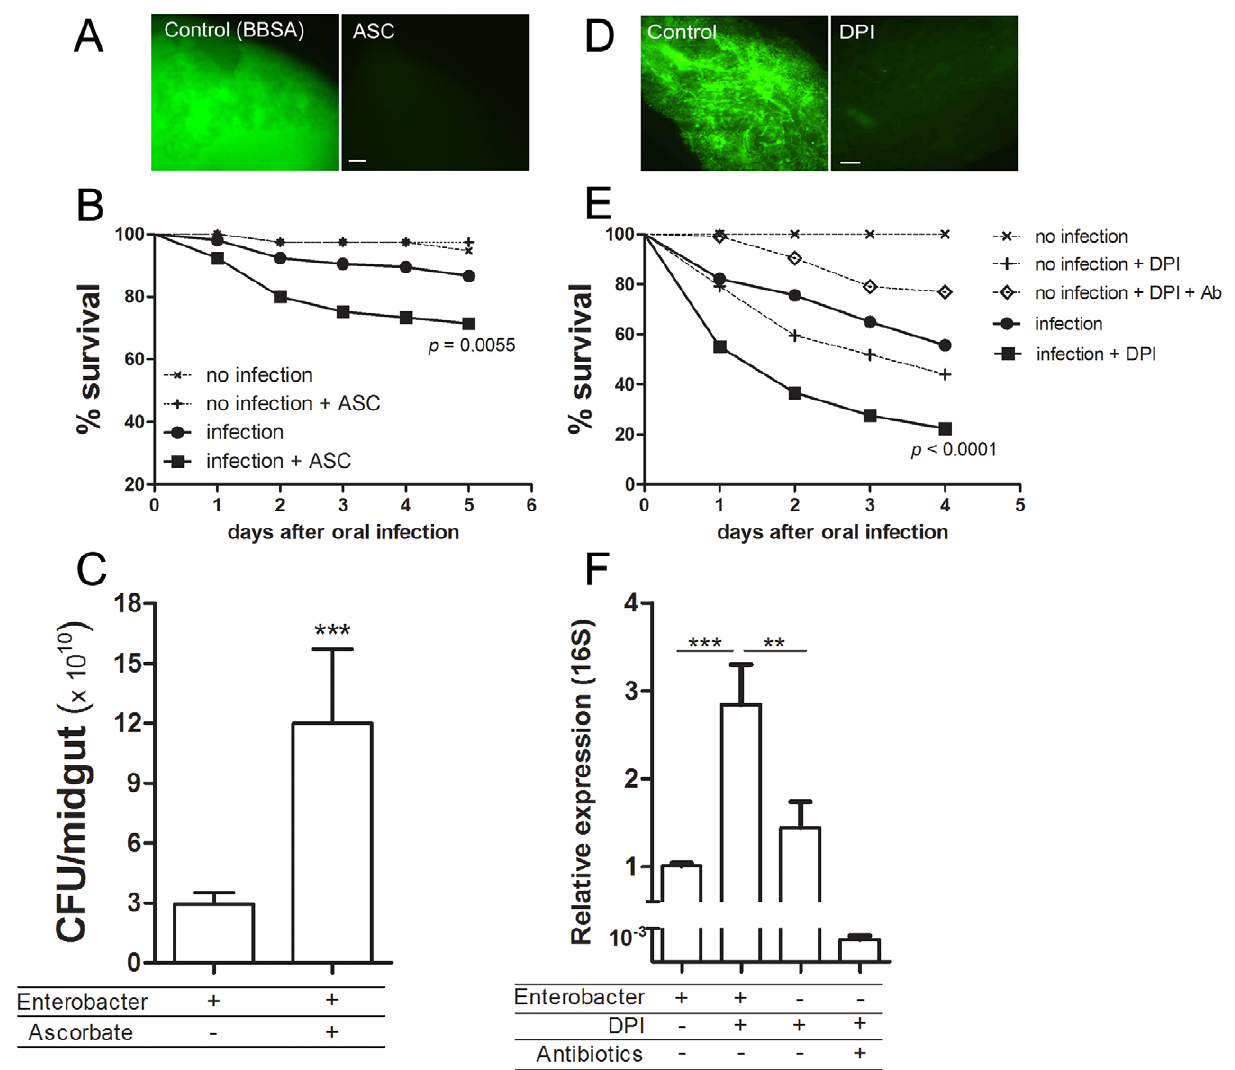
Figure 8. Redox modulation of bacterial growth in the midgut. (A) Female mosquitoes were fed with BBSA + ascorbic acid (ASC) (50 mM pH 7) and immediately dissected and ROS levels were determined based on CM-H 2 DCFDA fluorescence. (B) Females were fed with BBSA + gut commensal bacterium Enterobacter asburiae at a concentration of 2 6 10 9 CFU/mL with or without ascorbic acid (50 mM) and were scored for survival daily. Data was analyzed with the Log-rank Test (GraphPad Prism 5). P =0.0055 between ‘‘infection’’ and ‘‘infection + ASC’’. The result shown is the sum of 3 independent experiments. Total number of mosquitoes: Control (n=40). Control + ASC (n=40). Infection (n=105). Infection + ASC (n=105). (C) In a different group of experiments using the same infection setup as in Figure 7B, mosquitoes were surface sterilized and dissected (5 midguts/ pool; 24 h after bacterial oral infection) and the number of CFU/midgut was determined. Figure 8C is the result of a representative experiment using 15 pools per condition. *** P , 0.0001 following a Kolmogorov-Smirnov Comparison test. (D) Sugar-fed midguts were pre-incubated for 1 h in medium alone (control) or medium supplemented with diphenylene iodonium (DPI, 10 m M) and stained for ROS with CM-H 2 DCFDA. Scale represents 100 m m. (E) Females were fed with BBSA supplemented Enterobacter asburiae at a concentration of 4 6 10 9 CFU/mL with or without DPI (10 m M), as well as BBSA + DPI with or without antibiotics (penicillin/streptomycin/tetracycline – 200 U/mL, 200 m g/mL, 100 m g/mL, respectively) and scored for survival daily. The total number of mosquitoes was 123 for ‘‘infection’’ 120 for ‘‘infection + DPI’’, 30 for ‘‘no infection’’, 106 for ‘‘no infection + DPI’’ and 120 for ‘‘no infection + DPI + Ab’’. The result shown is the sum of 3 independent experiments. P , 0.0001 for the comparison between ‘‘infection’’ and ‘‘infection + DPI (Log-rank Test – GraphPad Prism). (F) RNA from whole body (minus head) of pools of 5 mosquitoes was extracted and quantification of bacterial 16S RNA was performed using 6 independent pools of mosquitoes. ** P , 0.01. *** P , 0.0001 (ANOVA followed by Tukey’s Multiple Comparison Test – GraphPad